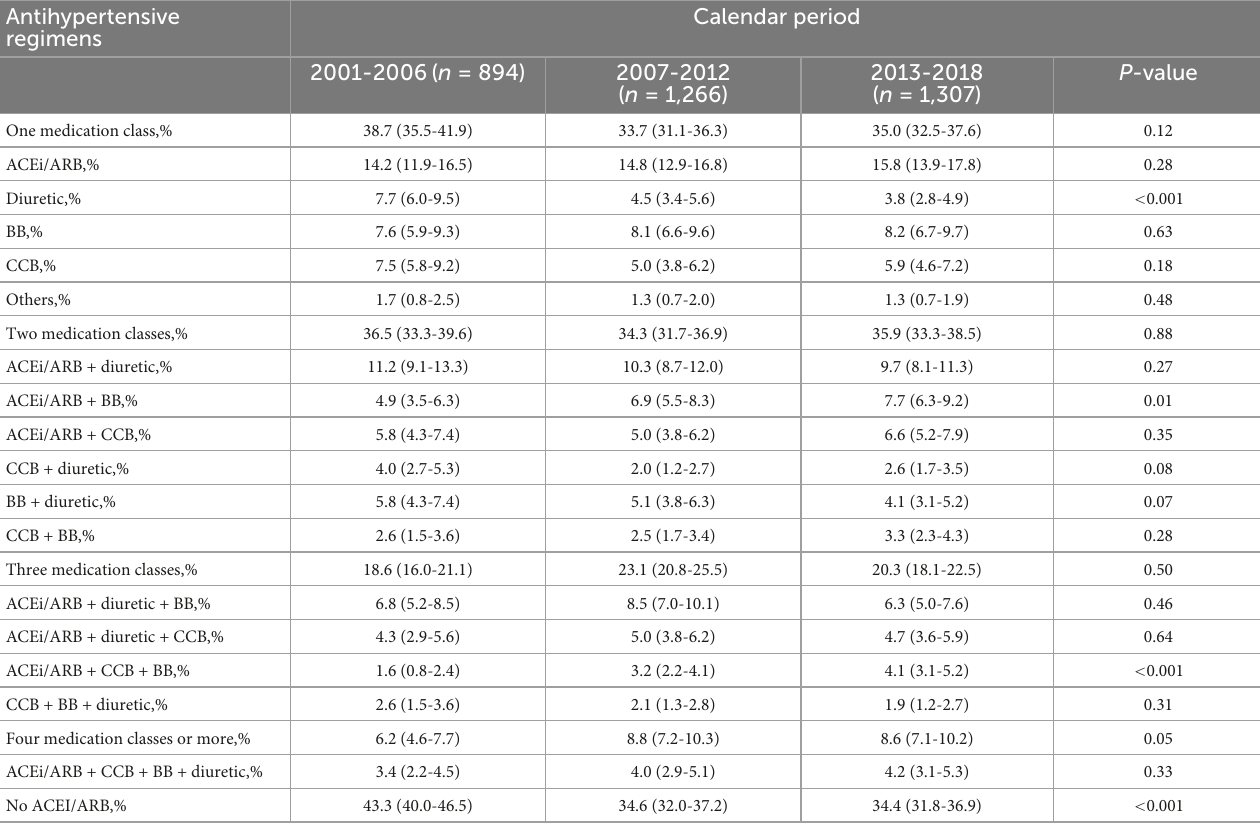
TABLE 3 Proportion of antihypertensive medication use among adult CKD patients with uncontrolled blood pressure (according to 2021 KDIGO guideline) taking antihypertensive agent in 2001-2006, 2007-2012, and 2013-2018. Antihypertensive